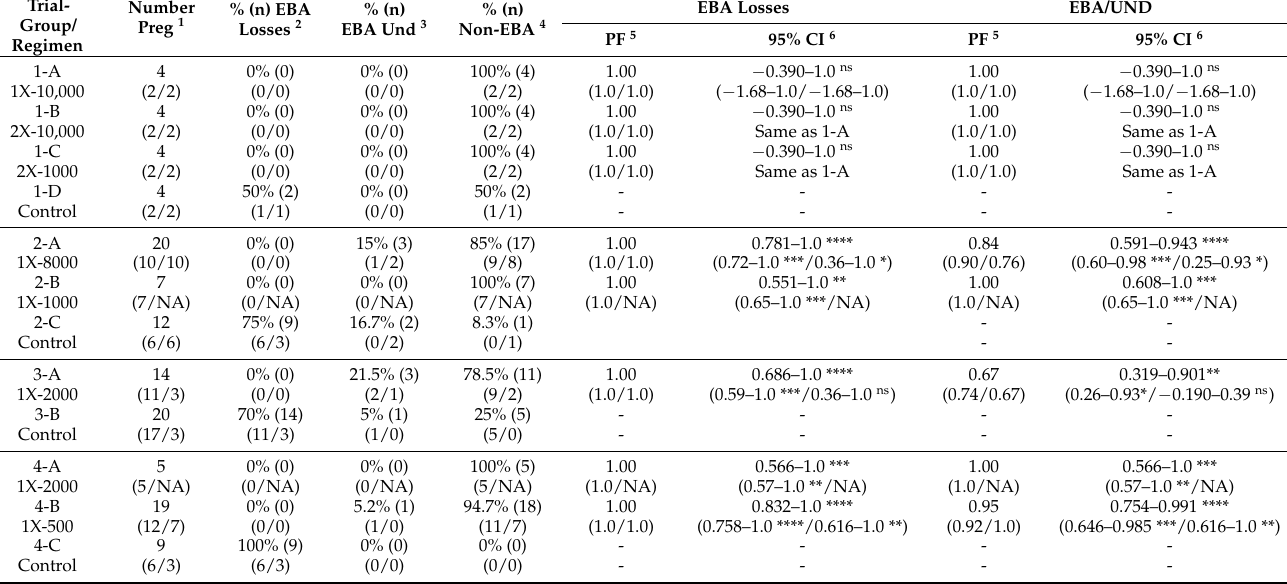
Table 3. Vaccine